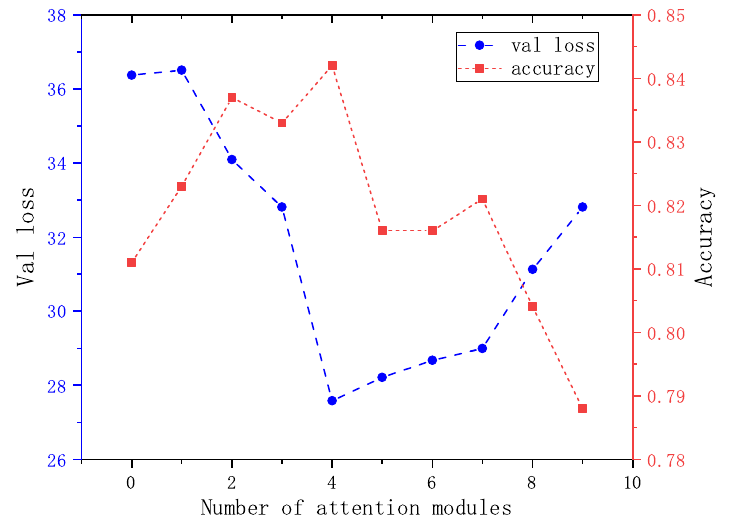
Figure 8. The relationship between the number of attention modules and network